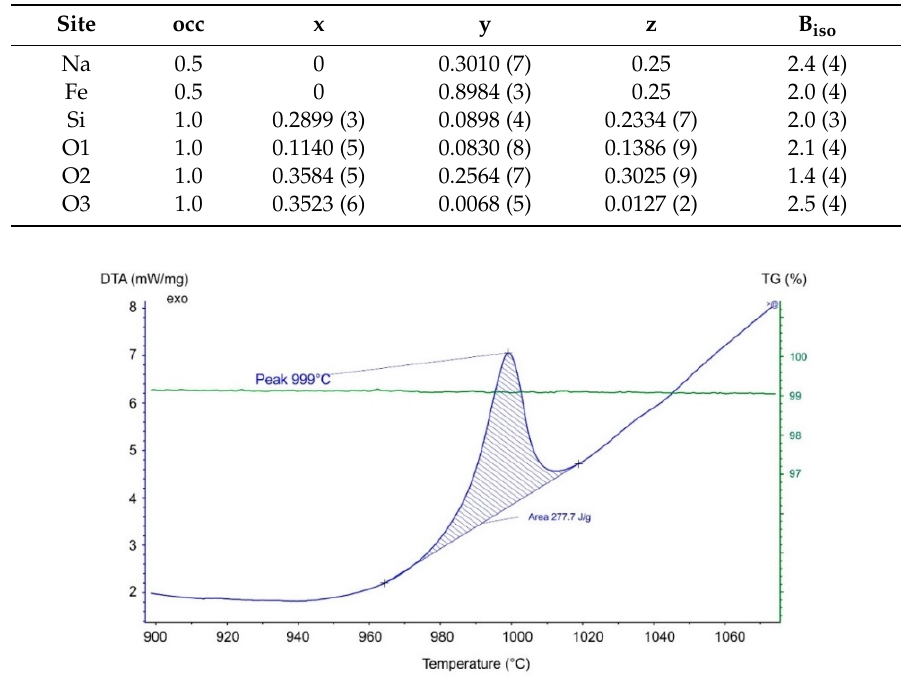
Figure A1. Part of the DTA run on a synthetic aegirine, synthesized at 230 °C and 24 h, the peak at 999 °C corresponds to the melting temperature; a small weight loss at the beginning of the heating (10°/min in synthetic air) is due to some adsorbed water.